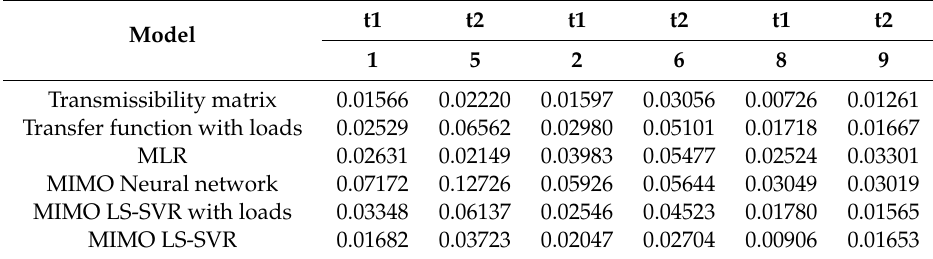
Table 4. Root mean square error (RMSE) of the predicted multi-point vibration response for di ff erent